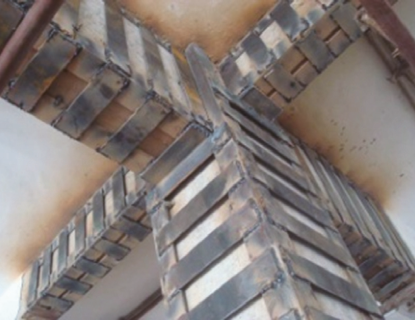
Figure 2: Diagram of reinforcement configuration of the frame beam section.